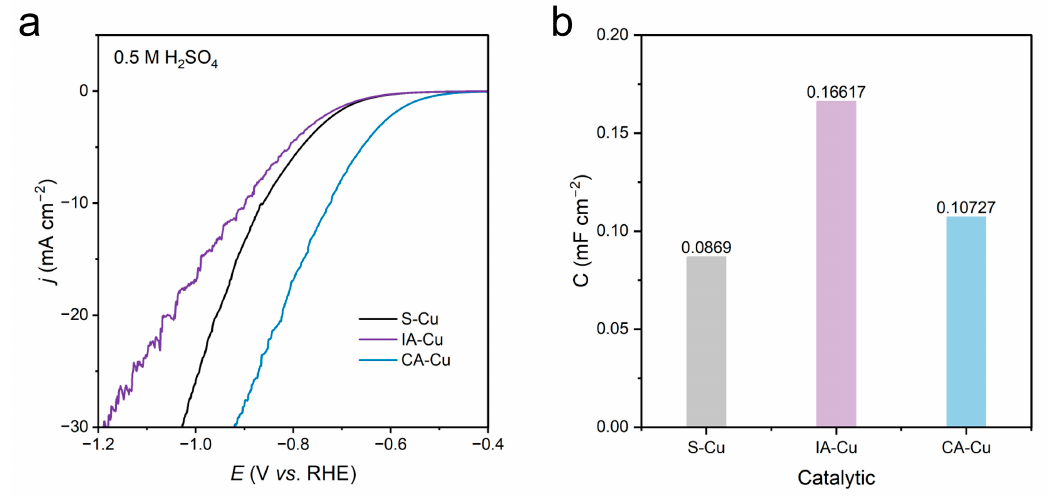
Figure 4. ( a ) LSV curves normalized by ECSA values, ( b ) DLC values of samples S-Cu, IA-Cu, and CA-Cu.